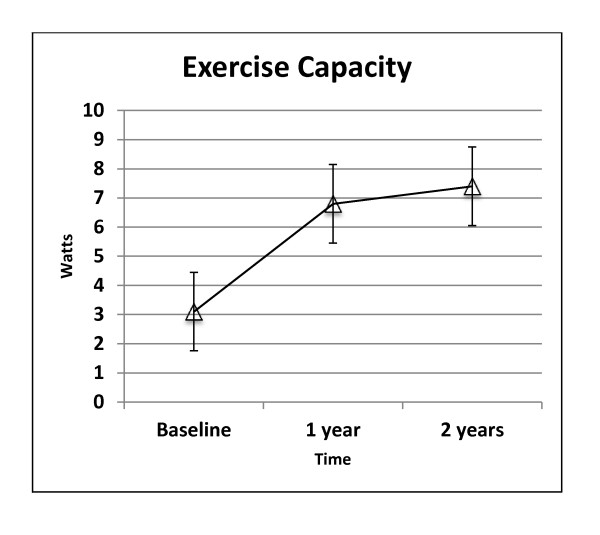
Exercise Capacity.